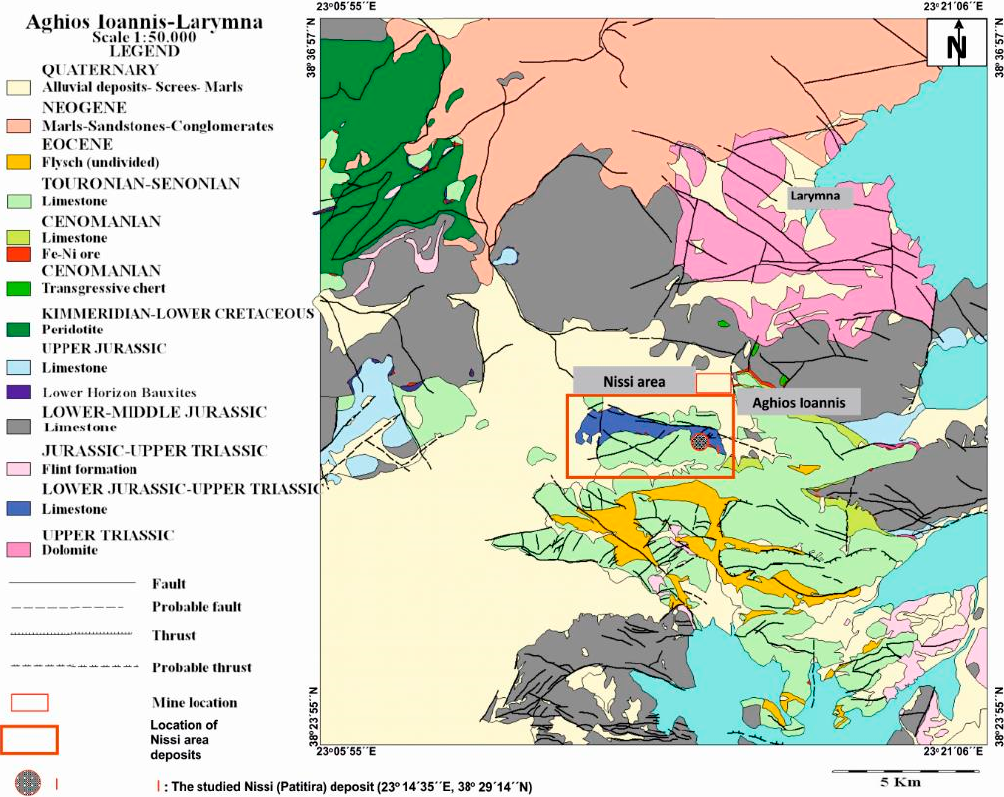
Figure 1. Simplified geological map, after GMM LARCO SA, cited in ProMine Project [2] showing the location of the studied deposit in Lokris area, Greece. The position of the sampled profiles is marked by the red cycle.